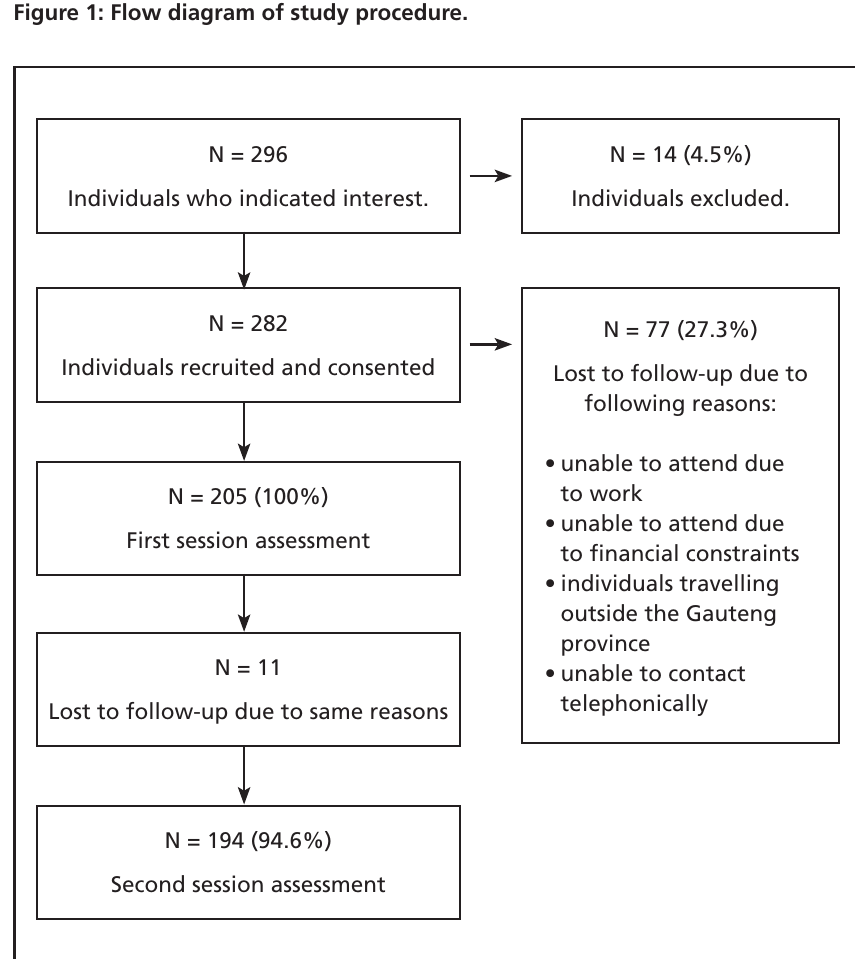
procedure.Session